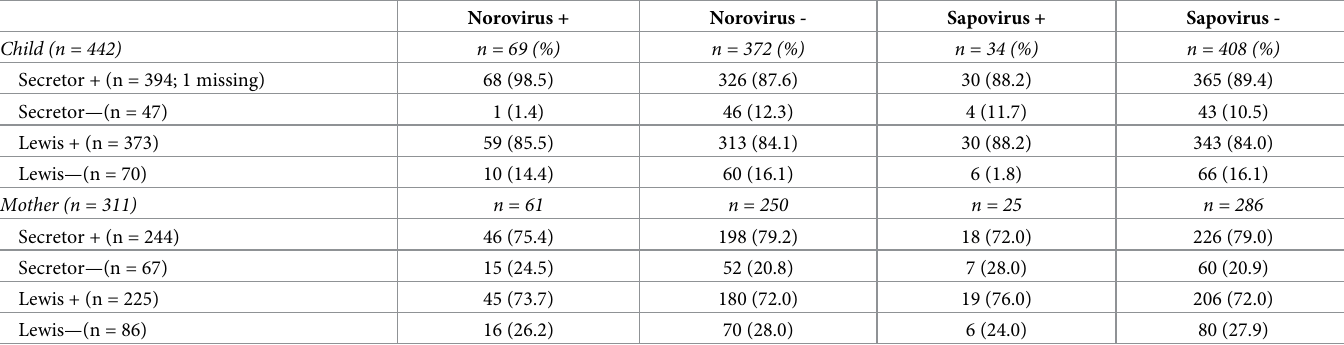
Table 2. Child and maternal host genetic factors and incidence of norovirus and sapovirus.